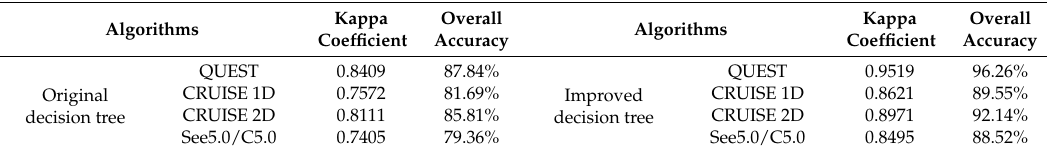
Table 8. Accuracy comparison derived from the original and improved decision tree, respectively.